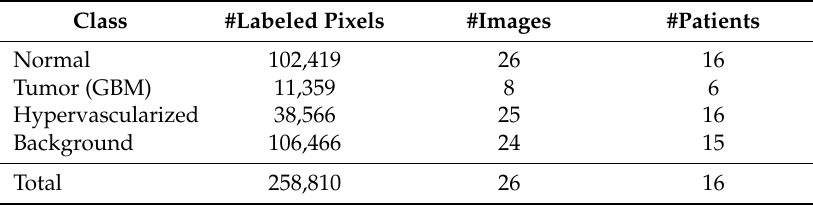
Figure 1. ( A ) Intraoperative hyperspectral (HS) acquisition system capturing an image during a surgical procedure. ( B ) Synthetic red–green–blue (RGB) representation of an HS cube from an in vivo brain surface affected by glioblastoma (GBM) tumor (outlined in yellow). ( C ) Input and output spectral signatures of each step of the pre-processing chain employed to pre-process the HS cube. ( D ) Gold standard map obtained with the semi-automatic labeling tool from the HS cube. Normal, tumor, hypervascularized and background classes are represented in green, red, blue, and black color, respectively. White pixels correspond with non-labeled data. ( E ) Average and standard deviation of the spectral signatures of the tumor (red), normal (green), and blood vessel/hypervascularized (blue) labeled pixels. Table 1. Summary of the HS-labeled dataset employed in this study.